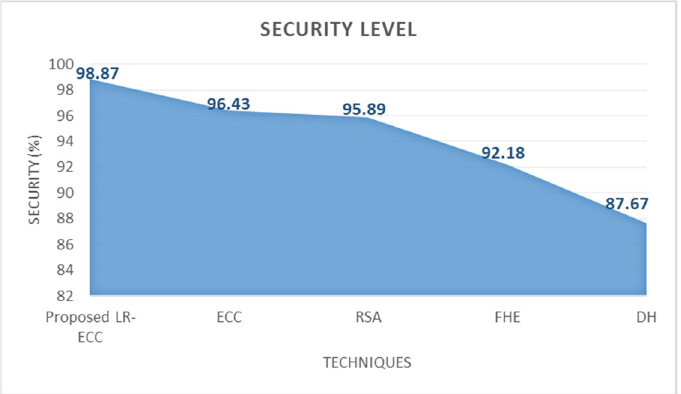
Figure 3. Security level analysis of the proposed LR-ECC methodology.